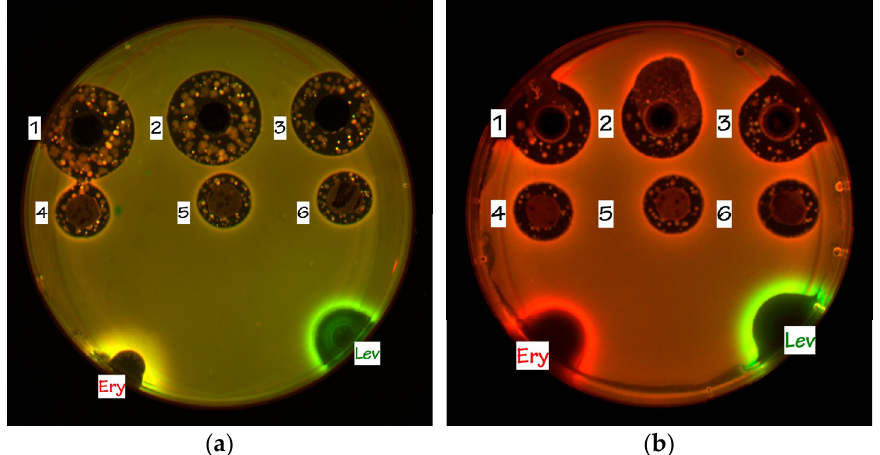
Figure 4. In Vitro testing of ant-associated strains activity using: ( a ) E. coli BW25113 wild-type pDualRep2 reporter strain; ( b ) E. coli JW5503 Δ tolC pDualRep2 reporter strain. 1, 2, 3—crude broth aliquots and 4, 5, 6—agar plugs of X2, X1 and 4-3, accordingly. The agar plates were spotted with erythromycin, 5 µ g/mL (Ery) and levofloxacin, 2 µ g/mL